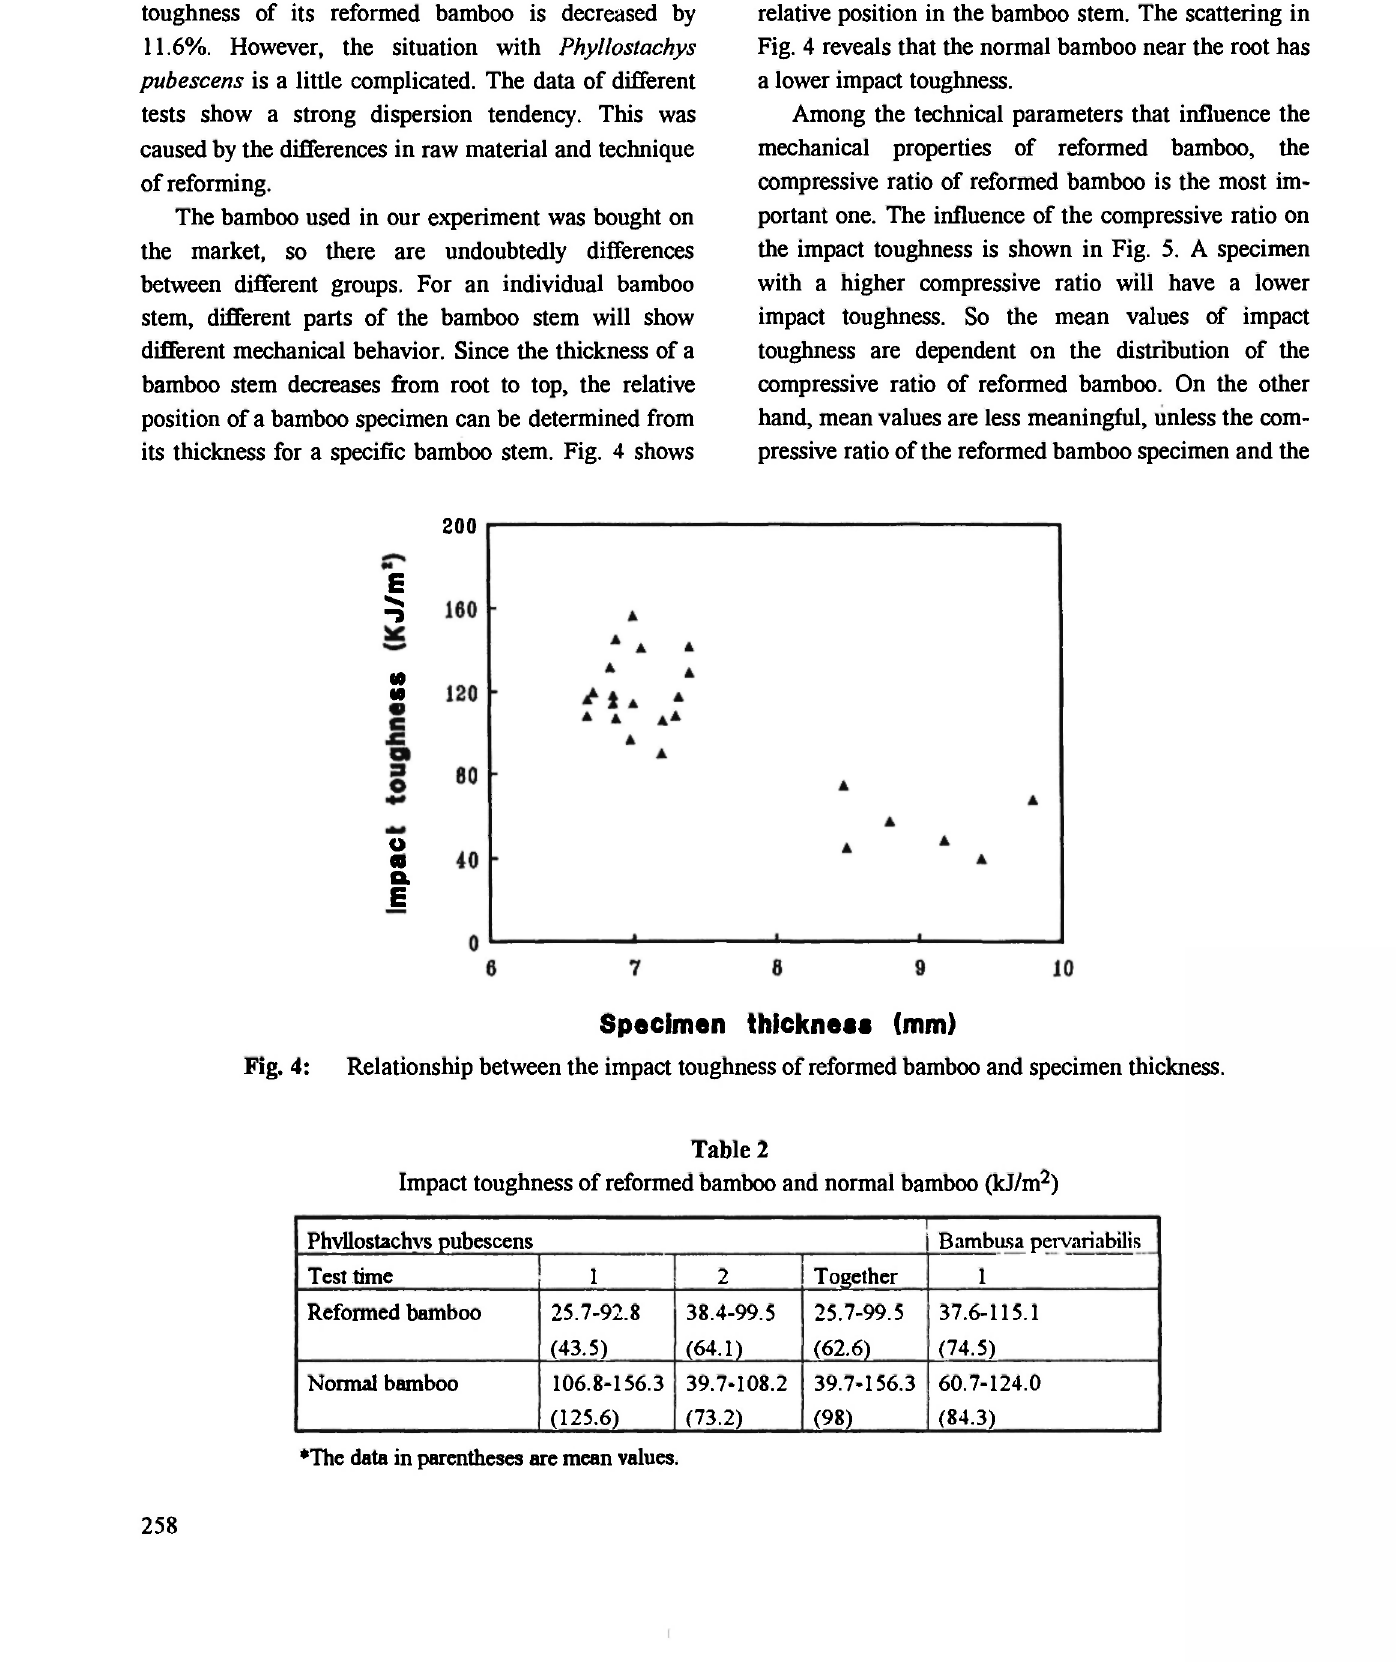
Table 2. For Bambusa pervariabilis, the impact